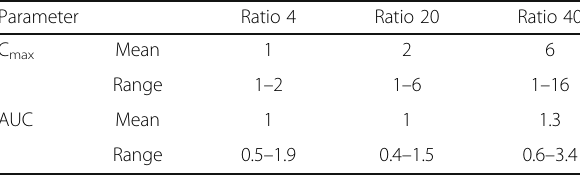
Table 1 Pharmacokinetic evaluation of Palladone XL ™ after co-ingestion of alcohol in fasted state (data from